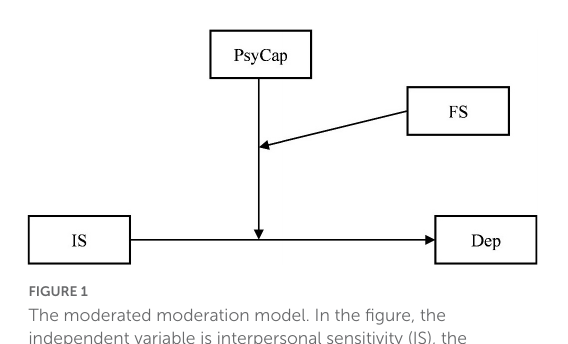
FIGURE1 The moderated moderation model. In the figure, the independent variable is interpersonal sensitivity (IS), the dependent variable is depression (Dep), and the moderators are psychological capital (PsyCap) and family support